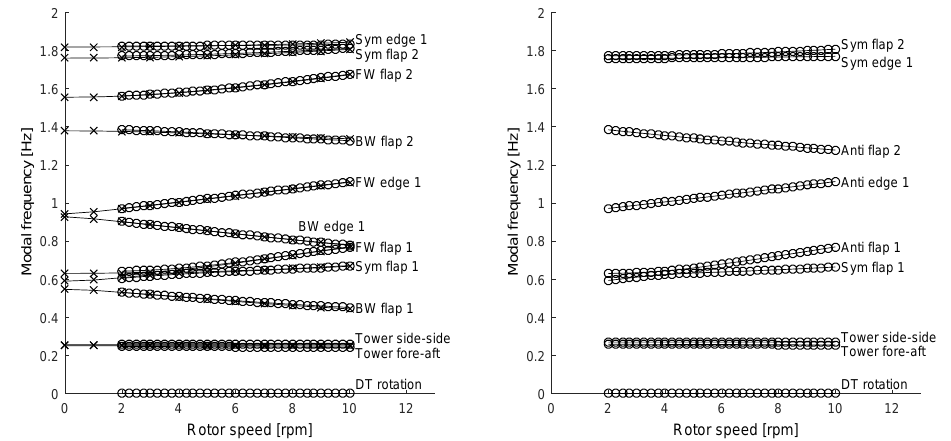
Figure 4. Campbell diagrams of the principal modal frequencies of the three-bladed (left plot) and two-bladed (right plot) version of the DTU 10MW RWT computed with Hill’s method (circles) and with the software HAWCStab2 (crosses) for the three-bladed